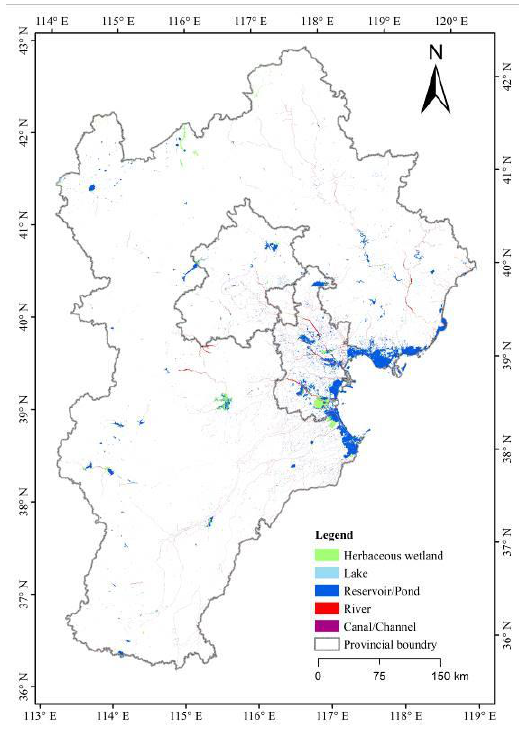
Figure 2. Wetland distribution in the Beijing-Tianjin-Hebei region (BTH) in 2015.